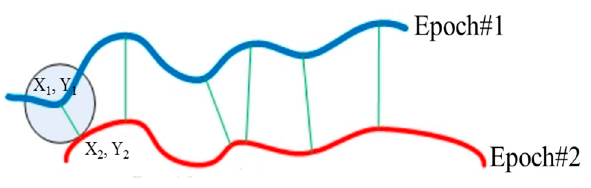
Figure 5. The procedure of calculating the horizontal displacement of the scarp retreat between the extracted epoch’s landslide scarps.